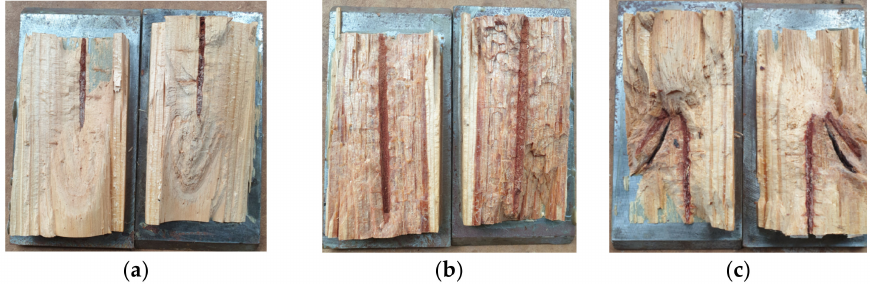
Figure 23. Some typical shear failures in ( a ) clear, ( b ) resin and ( c ) knots.